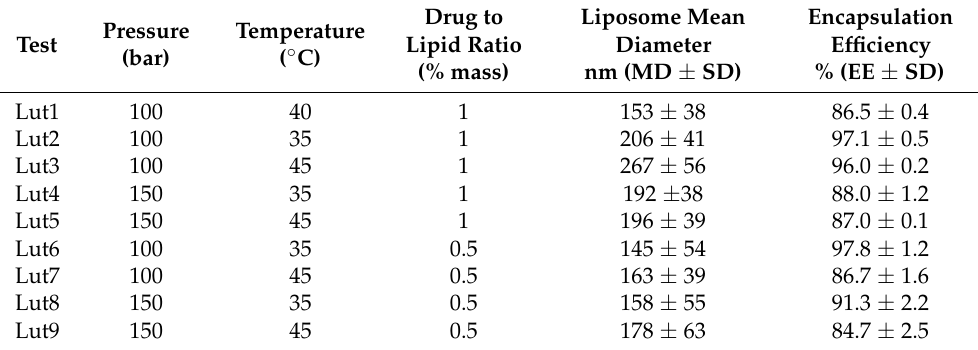
Table 3. Size, size distribution, and encapsulation efficiency for the experimental design performed for the encapsulation of